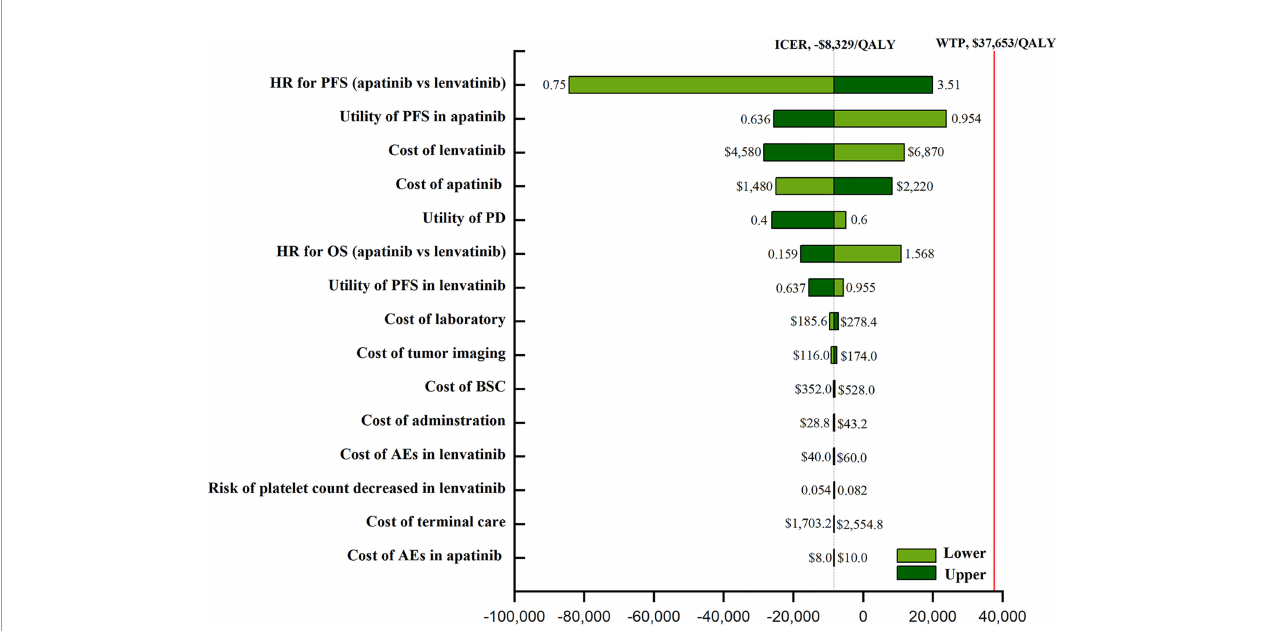
FIGURE 1 | The one-way sensitivity analyses of the apatinib vs Lenvatinib. PFS, progression-free survival; PD, disease progression; OS, overall survival; BSC, best supportive care; AEs, adverse